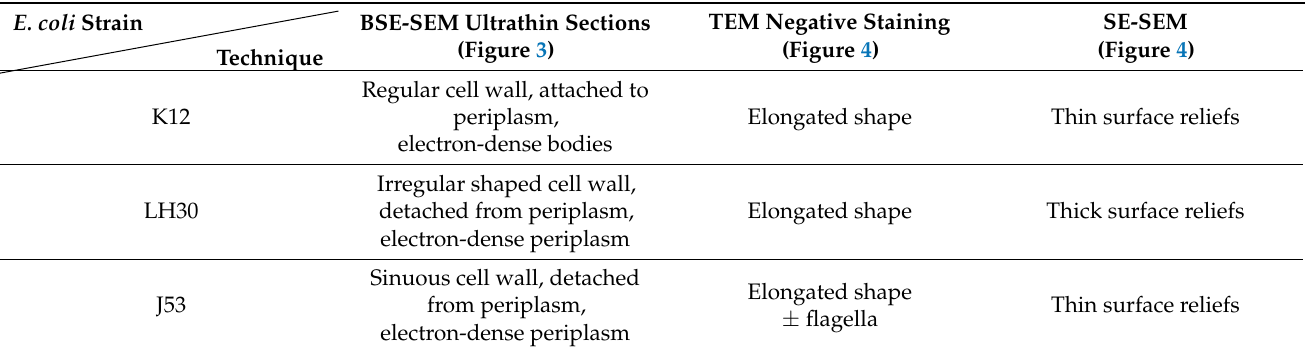
Table 3. Bacteria